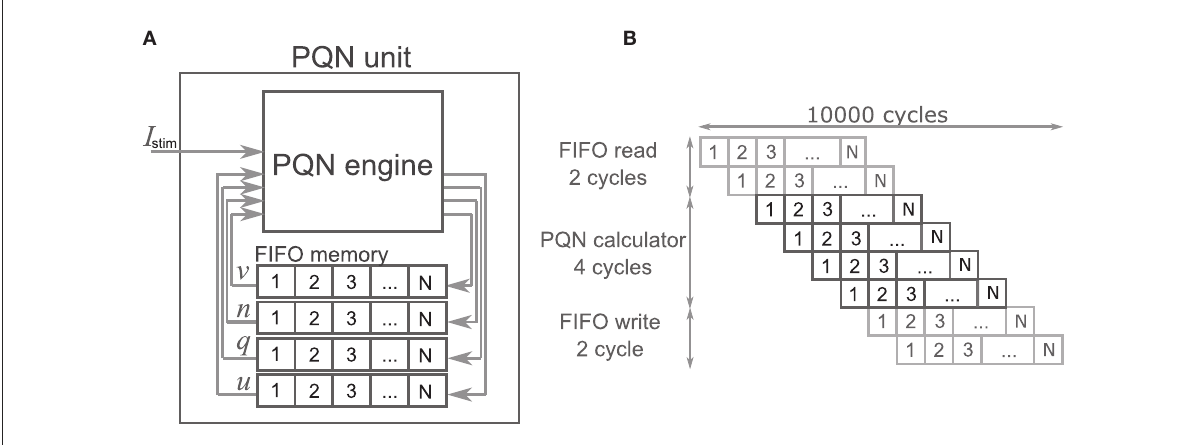
FIGURE4 The structure and clock cycle of the PQN unit. (A) The internal structure of the PQN unit. The state variables are stored in the FIFO memory and sent to the PQN engine in turn. (B) The clock cycle of the PQN unit.